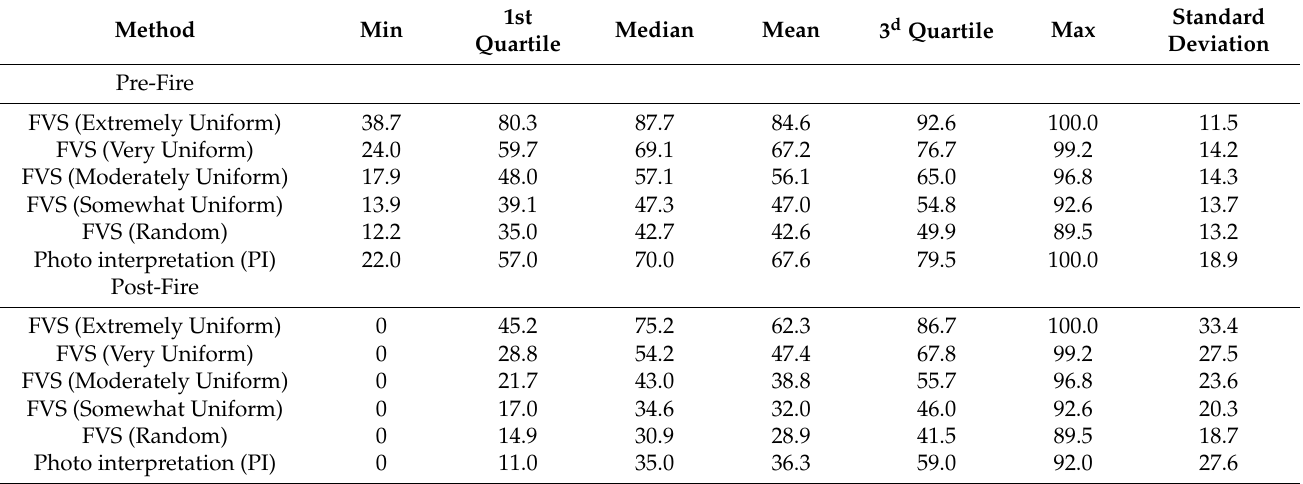
Table A1. Summary statistics for canopy cover (along with 5 different levels of canopy cover adjustment factor for FVS-generated values ranging from “random” tree spacing to “extremely uniform”) for the over-sampled